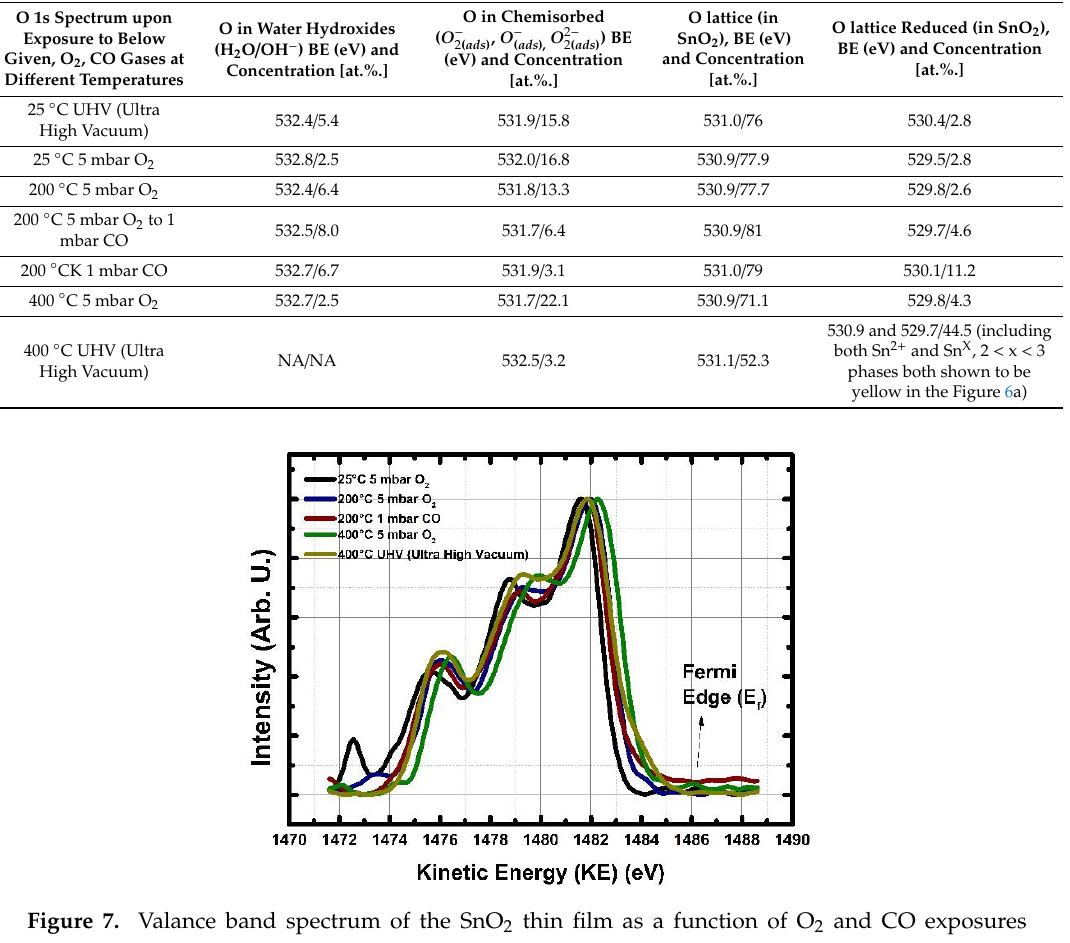
Table 2. Concentration and binding energies of di ff erent oxygen species upon exposure to 5 mbar of